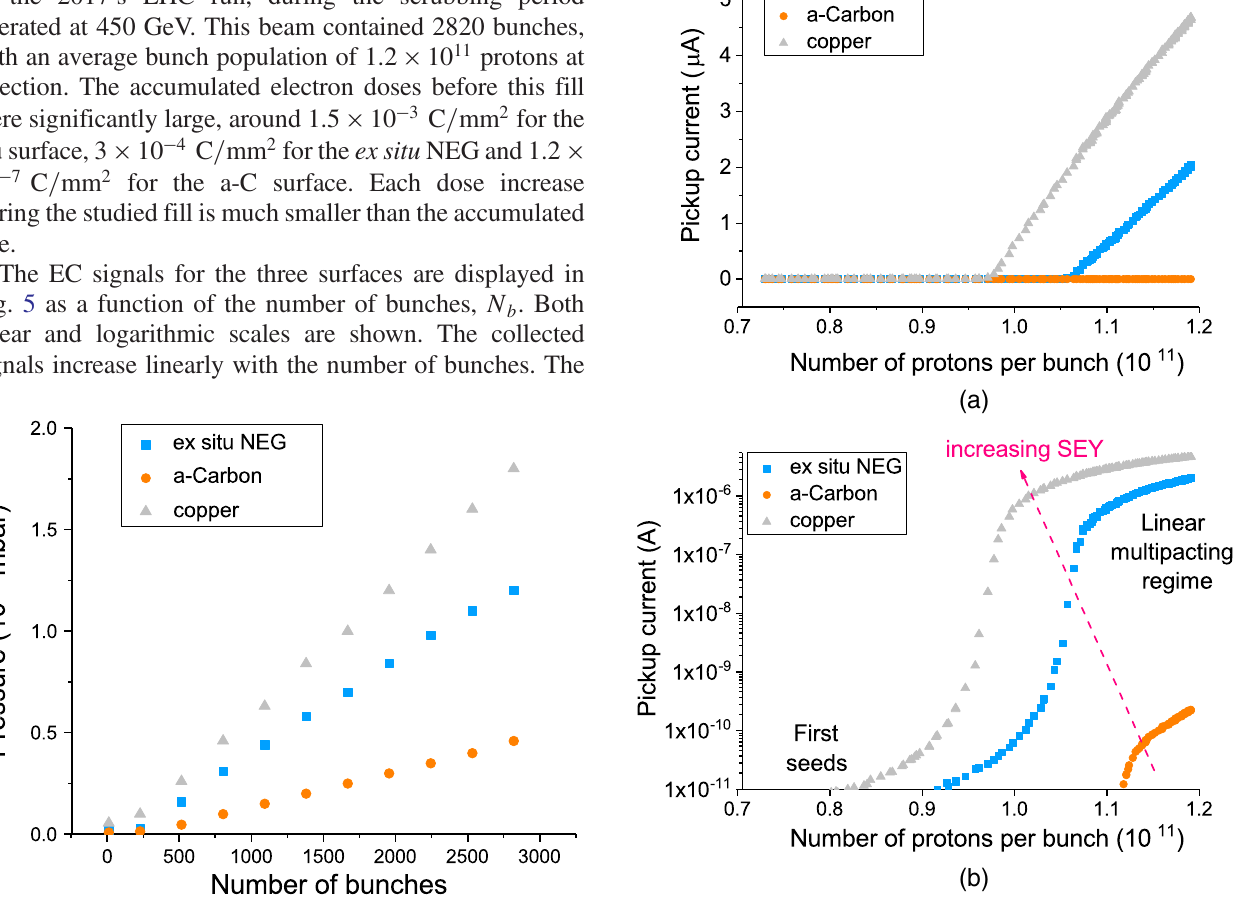
FIG. 7. Electrical signals as a function of the number of protons per bunch after the injection phase of a 25-ns standard LHC beam in linear (a) and logarithmic (b) scales at 450